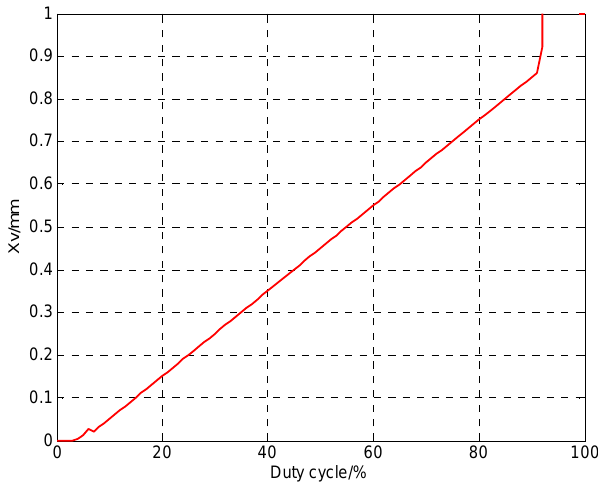
Figure 4. Signal–displacement simulation chart of digital valve.